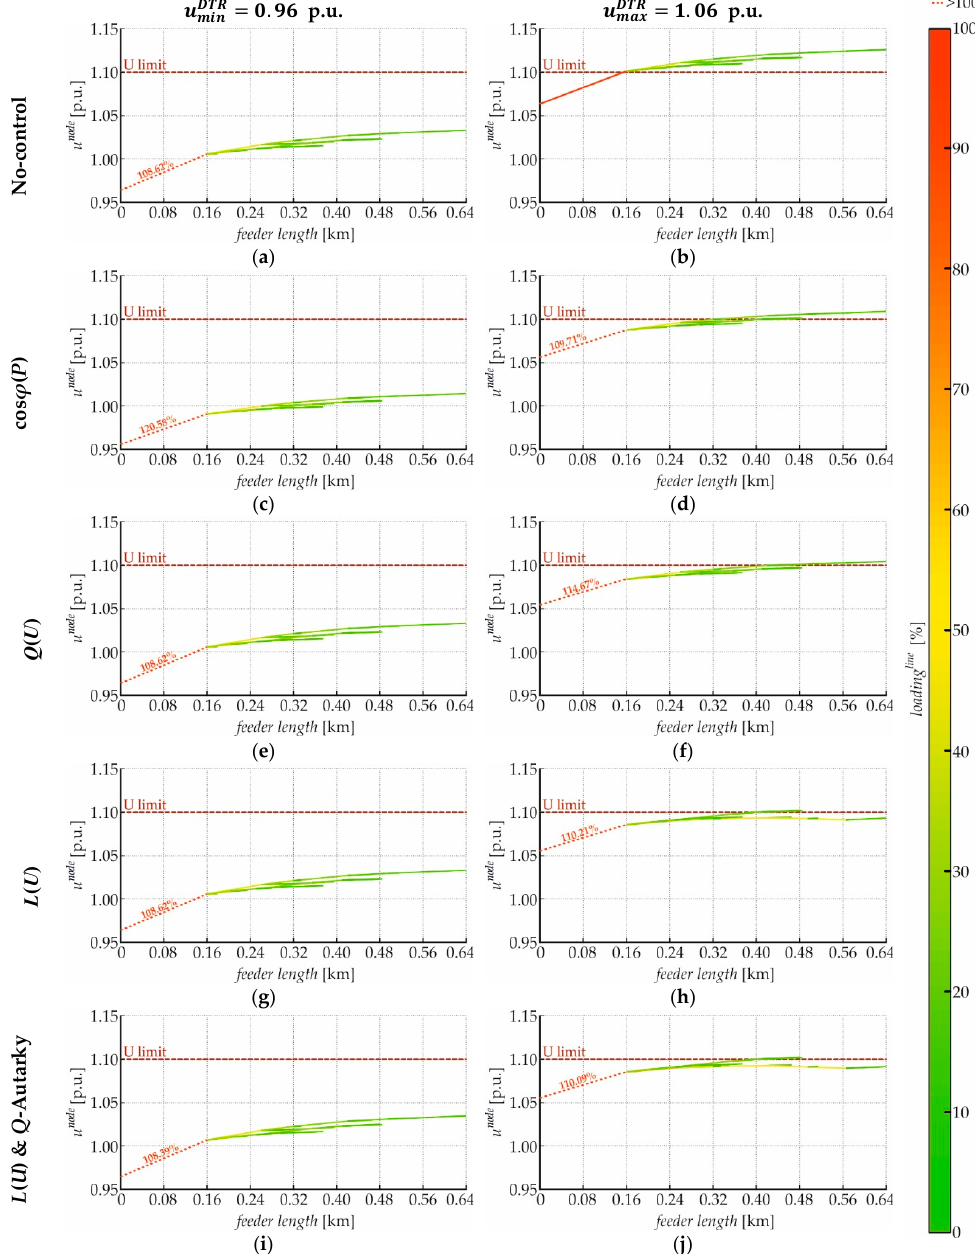
Figure 17. Voltage and current profiles of the branched cable test-feeder for a PV-penetration of 7.5 kW/prosumer, the minimal and maximal DTR primary voltages, and different control strategies: ( a , b ) no-control; ( c , d ) cos φ ( P )-control; ( e , f ) Q ( U )-control; ( g , h ) L ( U )-control; ( i , j ) L ( U )-control and Q -Autarkic prosumers.